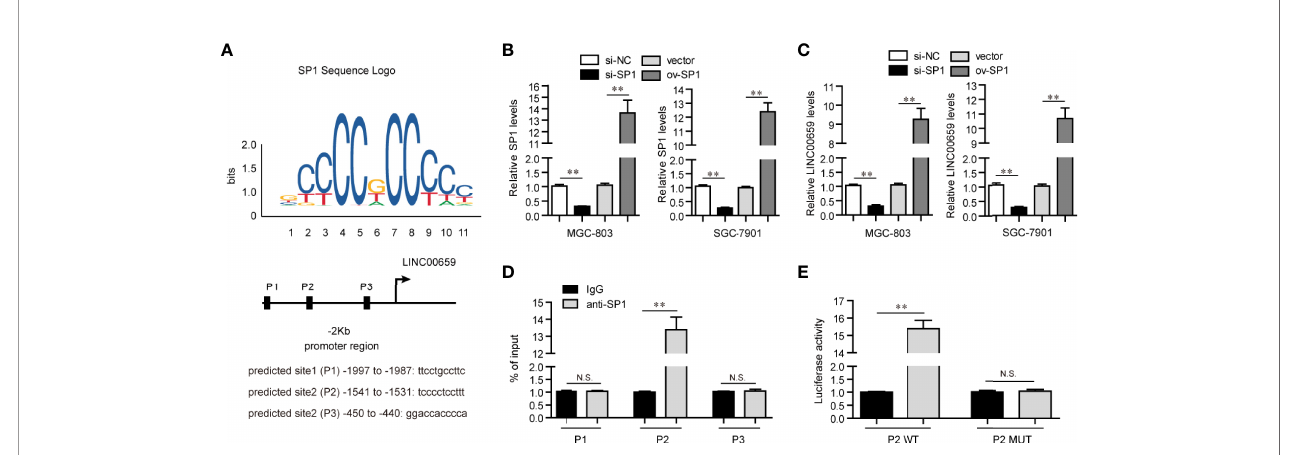
FIGURE 2 | SP1 mediated up-regulation of LINC00659 in GC cells. (A) “ Jaspar ” algorithm predicted SP1 binding sites in LINC00659 promoter sequence. (B) qPCR analyses detected SP1 levels in GC cells. (C) qPCR analyses detected LINC00659 levels in GC cells. (D) ChIP assays. (E) Luciferase activity detection. *P < 0.05, **P < 0.01. N.S., no signi fi cance.